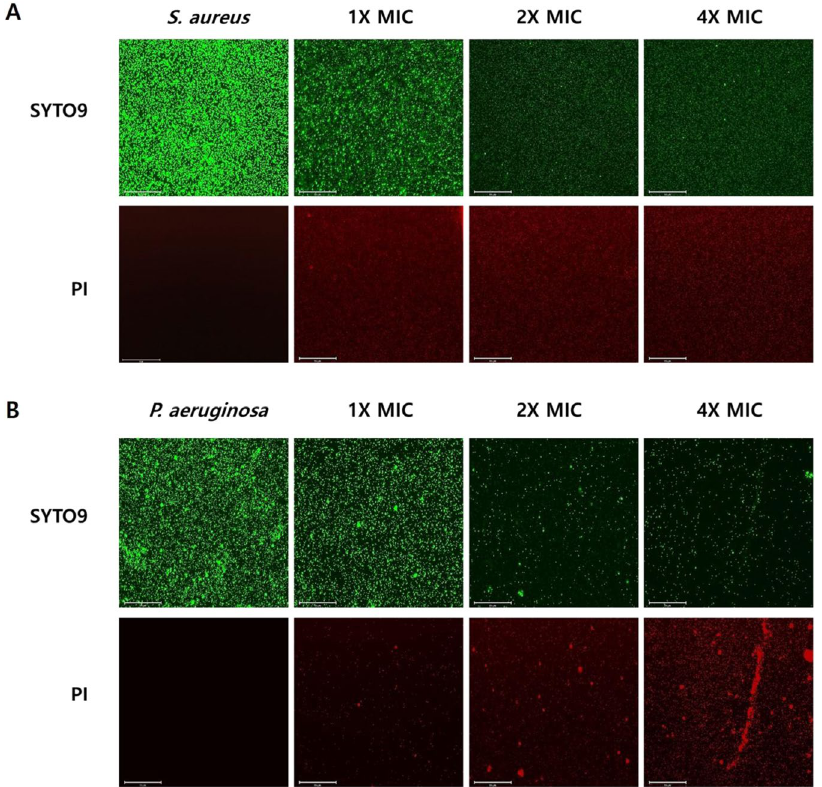
Figure 7. SYTO9/PI staining analyzed with microscopy. ( A ) Staphylococcus aureus ATCC 25923, ( B ) P. aeruginosa ATCC 27853 were treated with melectin and stained with SYTO9 and PI. Live bacteria appeared as green and dead bacteria appeared as